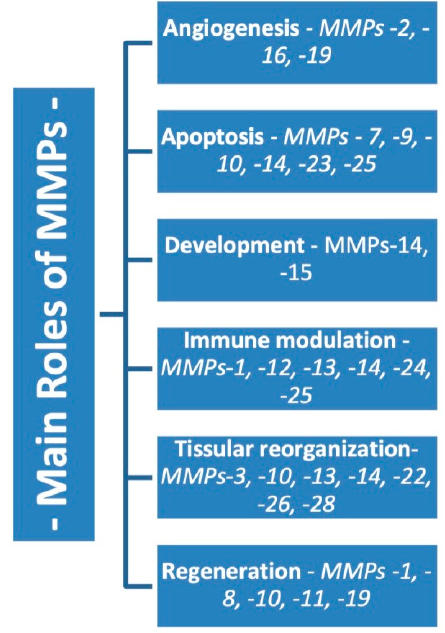
Figure 1. The main functions of matrix metalloproteinases.